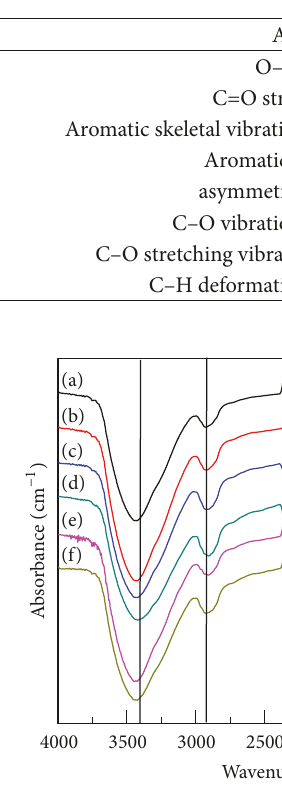
Figure 4: FT-IR spectra of the insoluble Eucalyptus fraction after treatment with different basic ionic liquids ((a) untreated; (b) [Mmim][DMP]; (c) [C5mim][Ac]; (d) [Bmim][Ac];